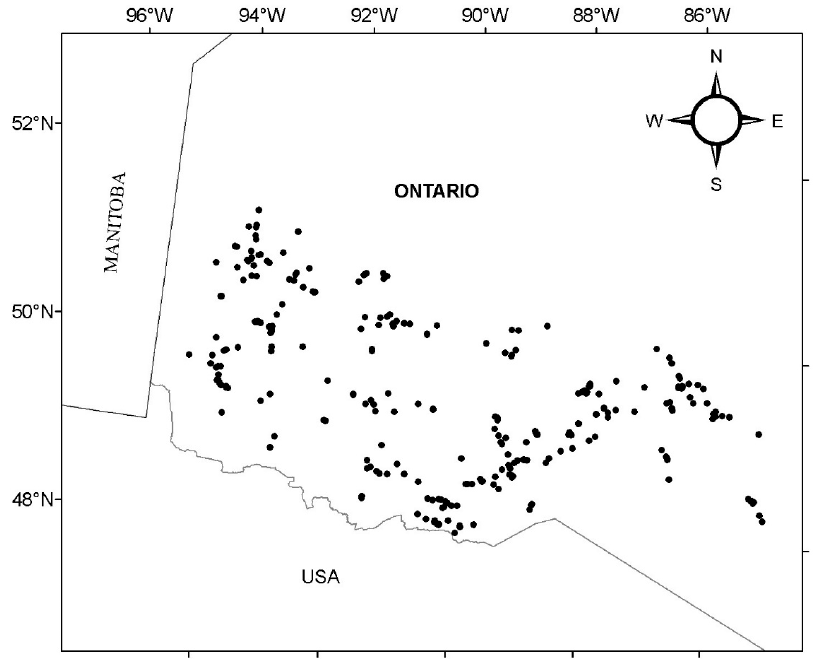
Figure 2. Study area map showing the distribution of the studied plots.